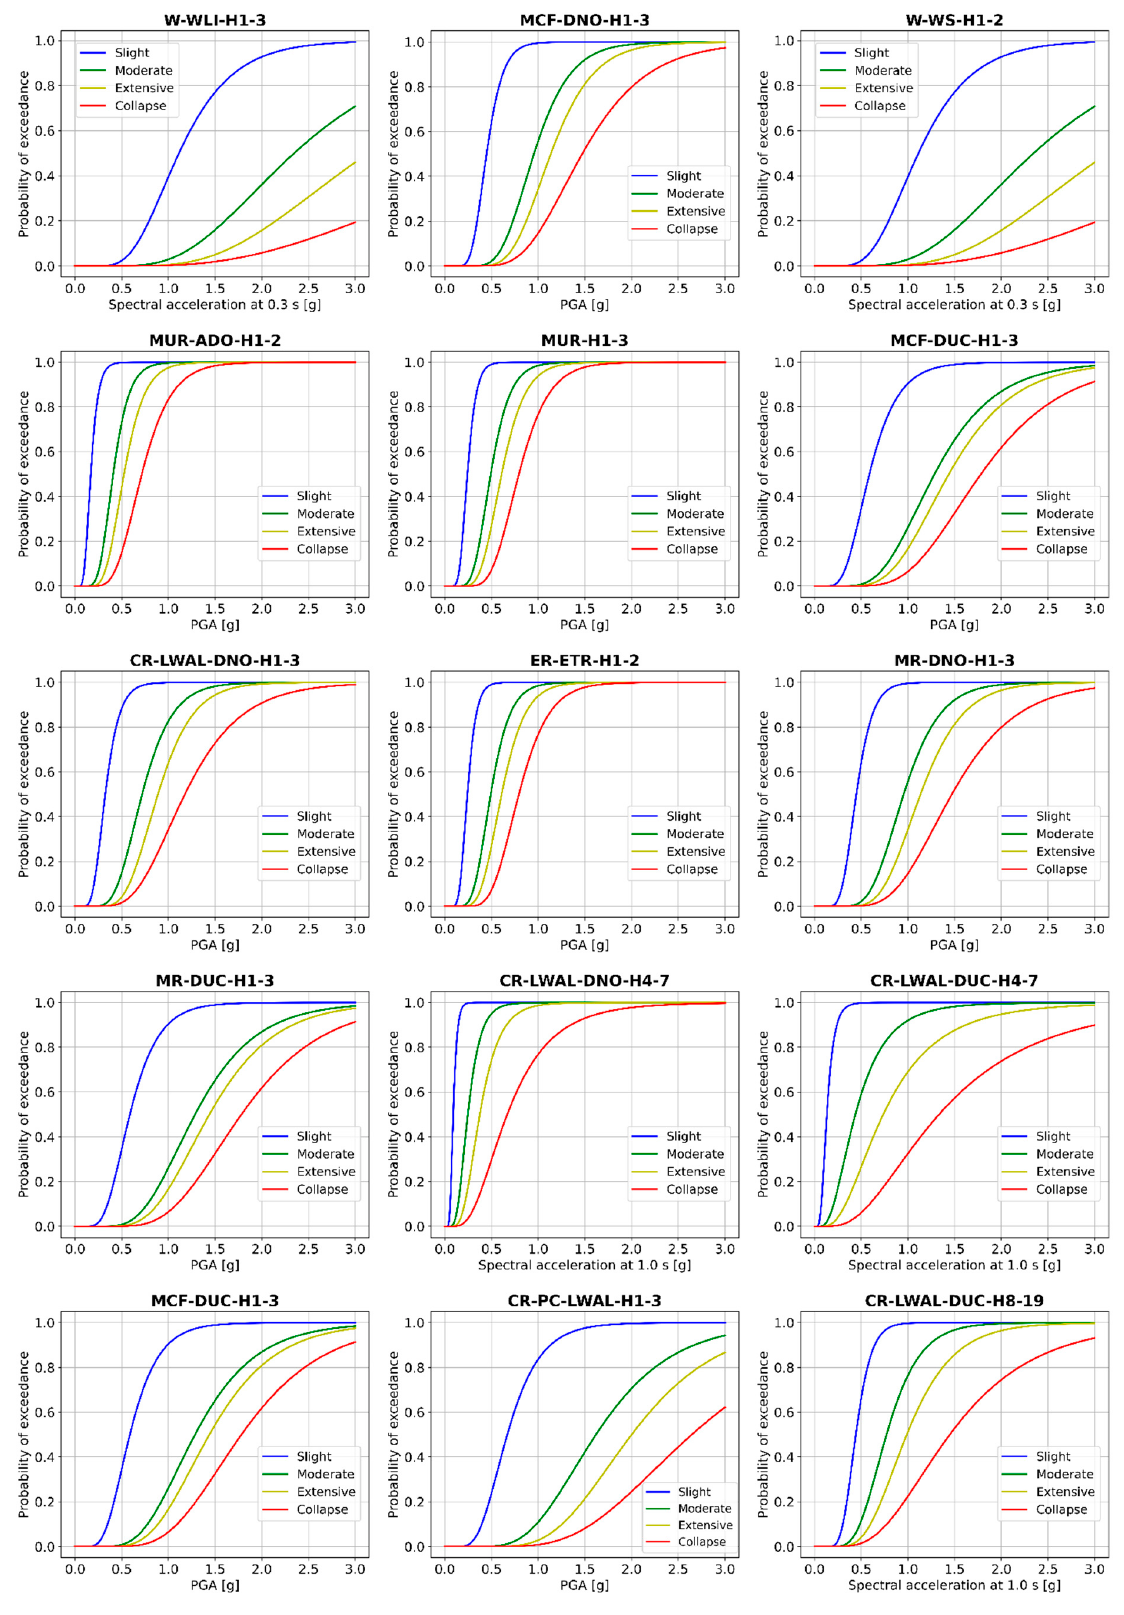
Figure 4. Fragility functions for 15 SARA building classes as reported in [69], describing their differential seismic vulnerabilities. The curves are presented in a similar order as in Figure 3.